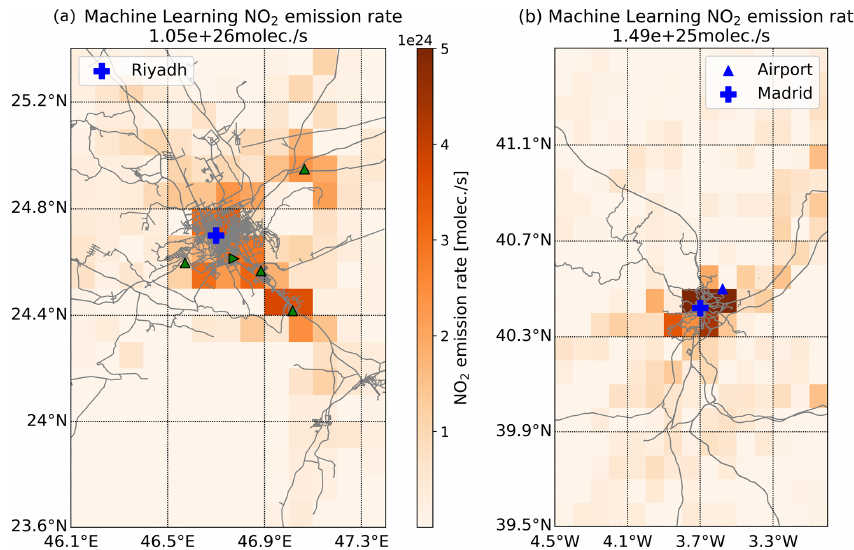
Figure 9. Panels (a) and (b) are similar to Figs. A4c and A5c, respectively, but using a spatially varying wind